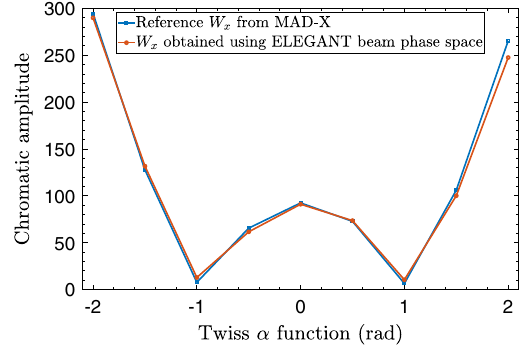
FIG. 8. Chromatic amplitude calculated using Eq. (4) with the phase space obtained from the ELEGANT simulation. The chro- matic amplitude evaluated for δ ¼ 0 is plotted in this figure. For comparison with the ELEGANT result, the chromatic amplitude was also computed using MAD - X [37]